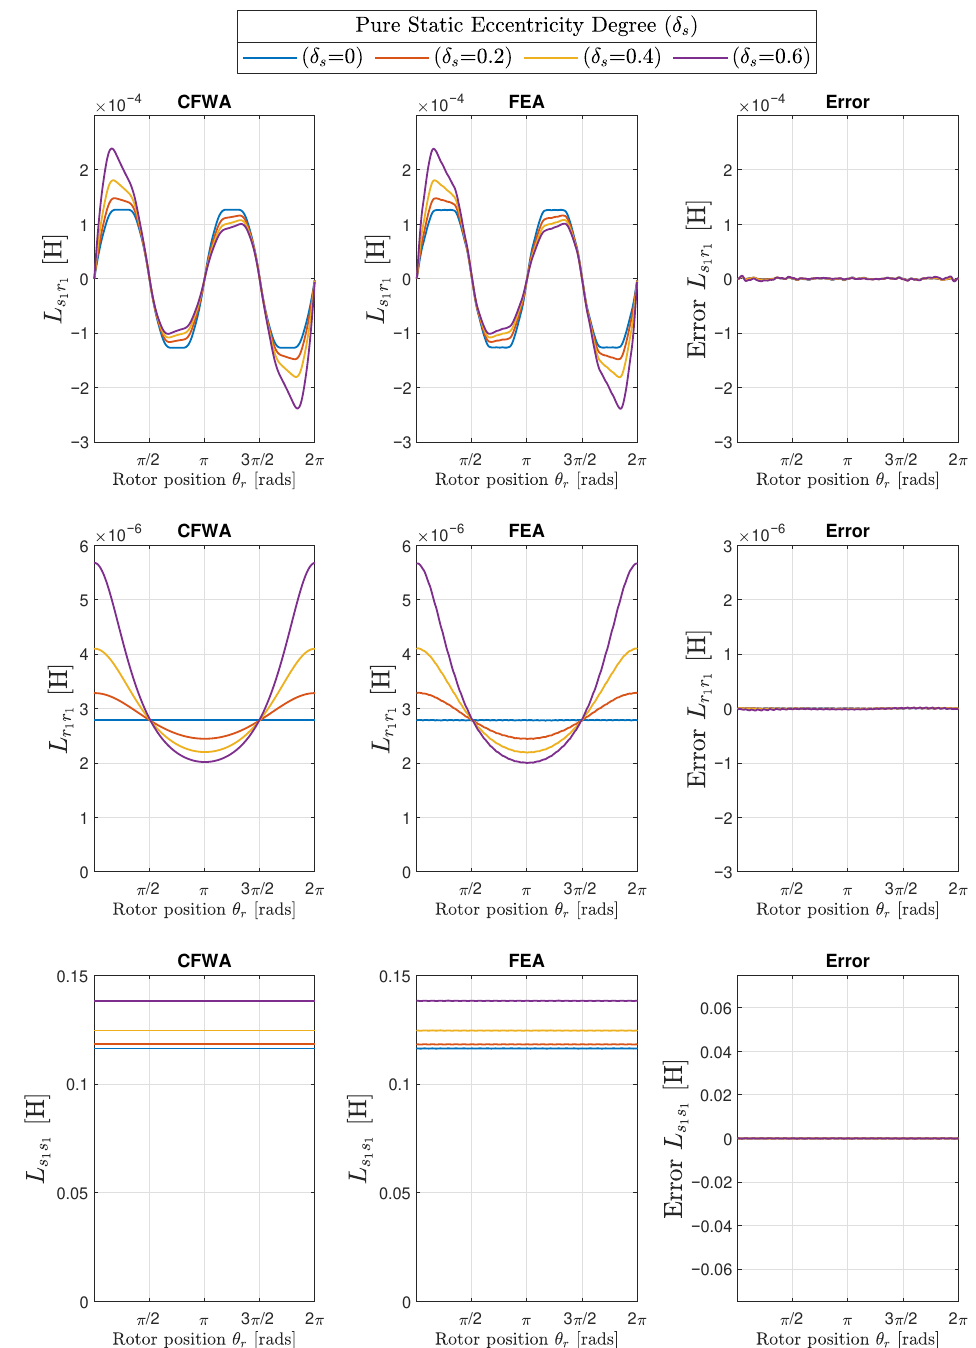
Figure 18. Mutual inductance between the first stator and the first rotor phase ( L s , top row ) and 1 r 1 self-inductances of the first rotor phase ( L r , middle row ) and of the first stator phase ( L r , bottom 1 r 1 1 r 1 row ) for the IM of Appendix A, with three different degrees of static ( δ s ) eccentricity: δ s = 0.2, δ s = 0.4, and δ s = 0.6. The case of healthy machine δ s = 0.0 has also been included for comparative purposes. The first column presents the results obtained with the conformal winding tensor approach, the second column presents the results obtained with FEA, and the third column presents the errors between both